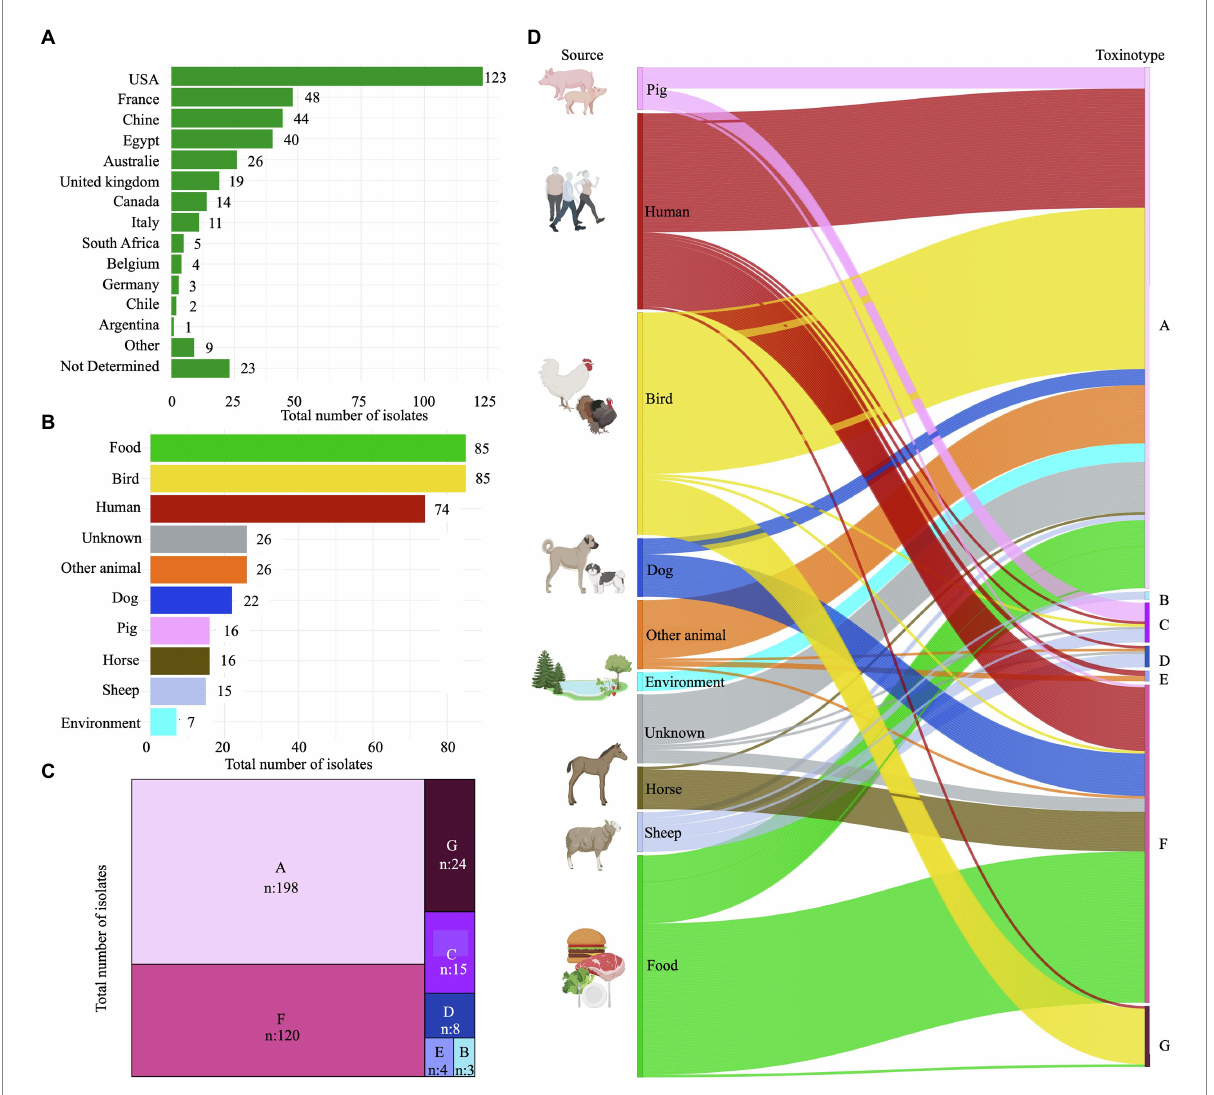
FIGURE 1 Origin and toxinotype profile of 372 Clostridium perfringens genomes. (A) Distribution of isolates by country of origin. (B) Distribution of isolates by source. (C) Distribution of isolates by toxin type. (D) Toxinotype diversity among hosts. All figures were created with R